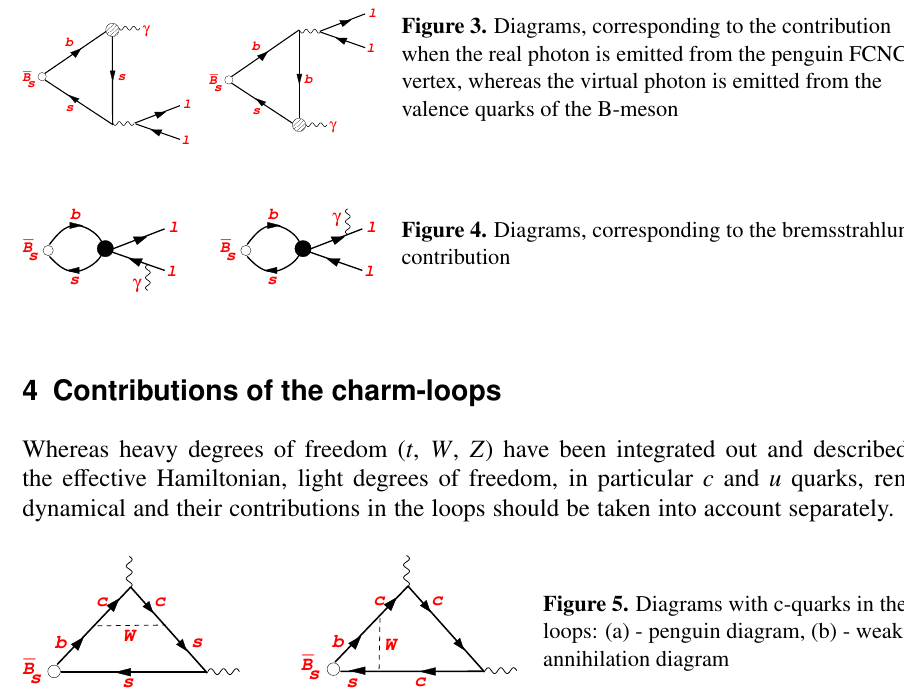
Figure 5. Diagrams with c-quarks in the loops: (a) - penguin diagram, (b) - weak annihilation